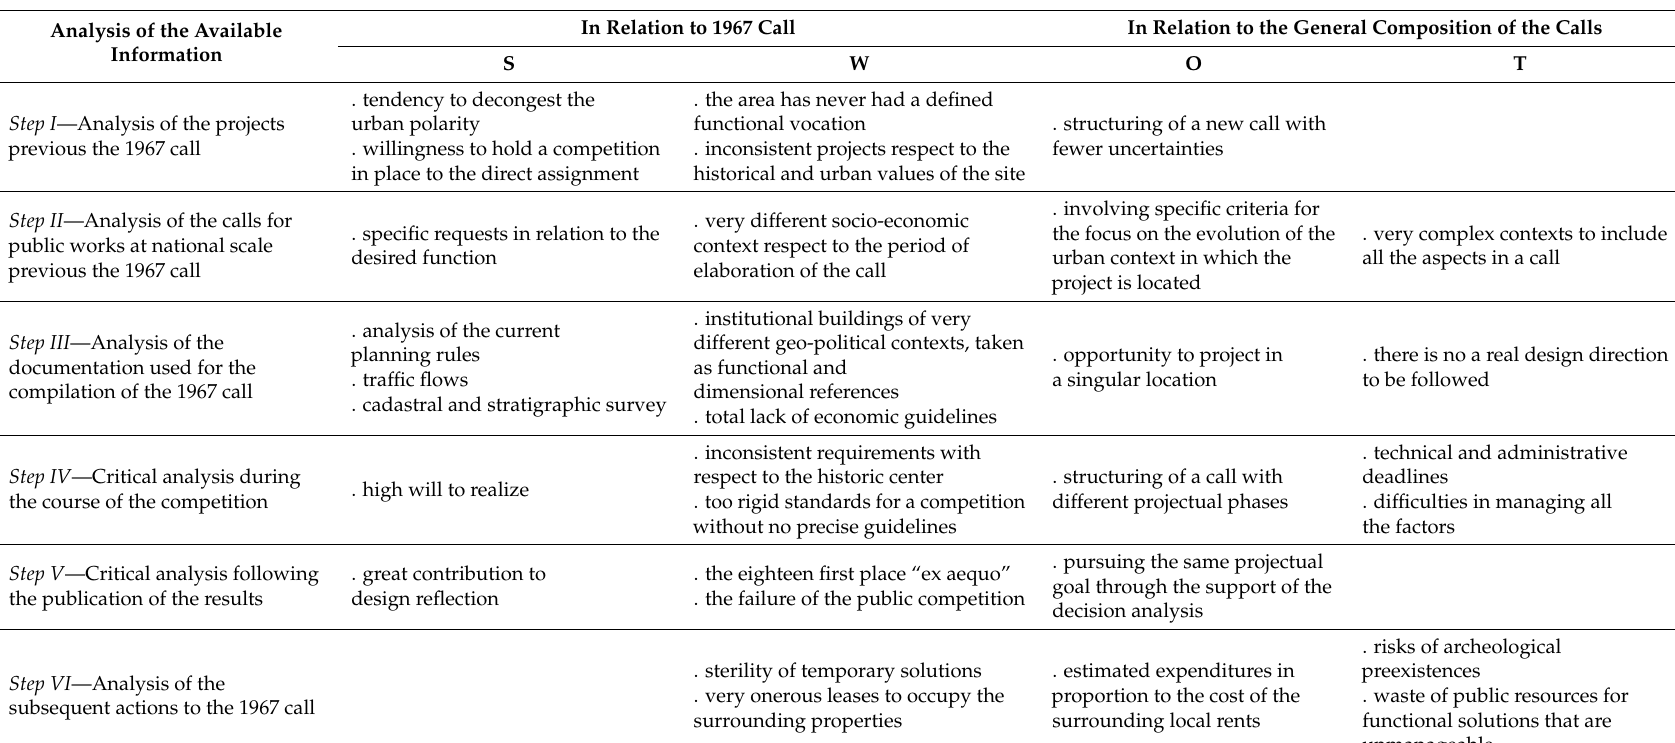
Table 4. Strengths, Weaknesses, Opportunities, and Threats (SWOT)